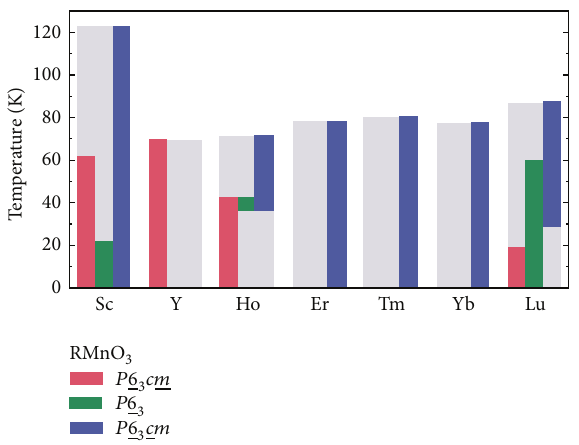
Figure 5: Magnetic symmetry of the hexagonal manganites. Sc, Ho, and Lu show a coexistence of magnetic phases with temperature intervals being sample specific. (Rare-earth spin ordering below 6K was not considered) [33]. Reprinted figure with permission from Fiebigetal.[33].Copyright(2000)bytheAmericanPhysicalSociety.